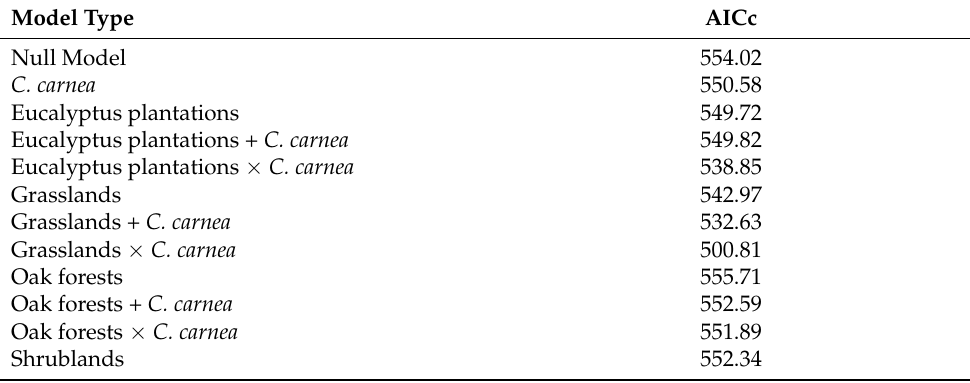
Figure 5. Infestation of P. oleae along a gradient of surrounding olive groves and different levels of C. carnea abundance. Red line represents the estimated effect of surrounding olive groves under a low abundance (red line) and high abundance (blue line) of C. carnea. Shaded areas represent the interval of confidence at 95%. Table 1. AICc models comparison for the studied variables of the P. oleae carpophagous generation eggs infestation on olive fruits during the complete study period and until the time lag settled at the 154 Julian day. The model with the lowest value of AICc is considered as the best model and conclusions are based on it. In bold best model